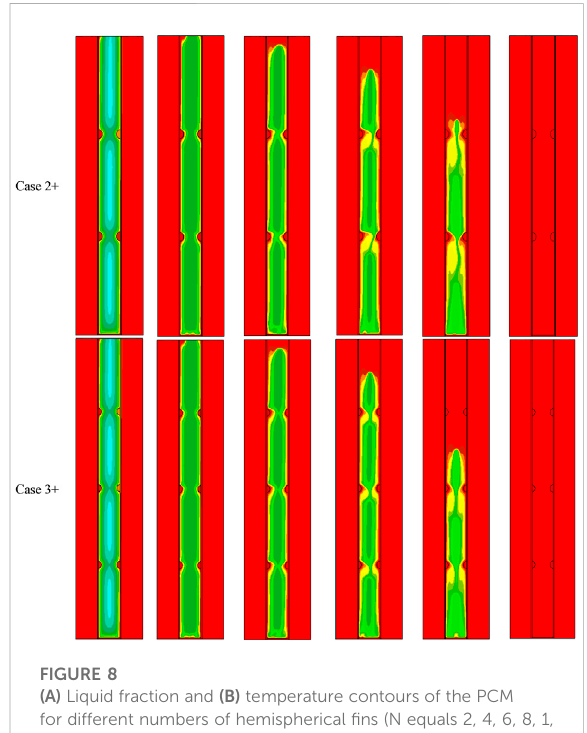
FIGURE 8 (A) Liquid fraction and (B) temperature contours of the PCM for different numbers of hemispherical fi ns (N equals 2, 4, 6, 8, 1, and 10) and added fi ns to the base of the PCM domain at various time